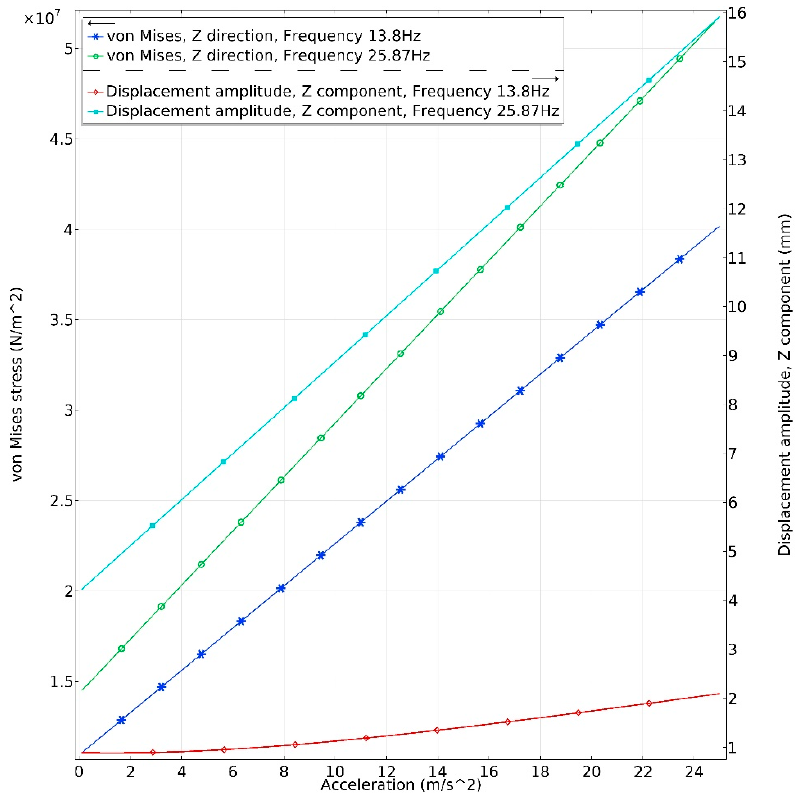
Figure 7. Dependence of maximum von Mises stress and tip displacement from acceleration in z direction.